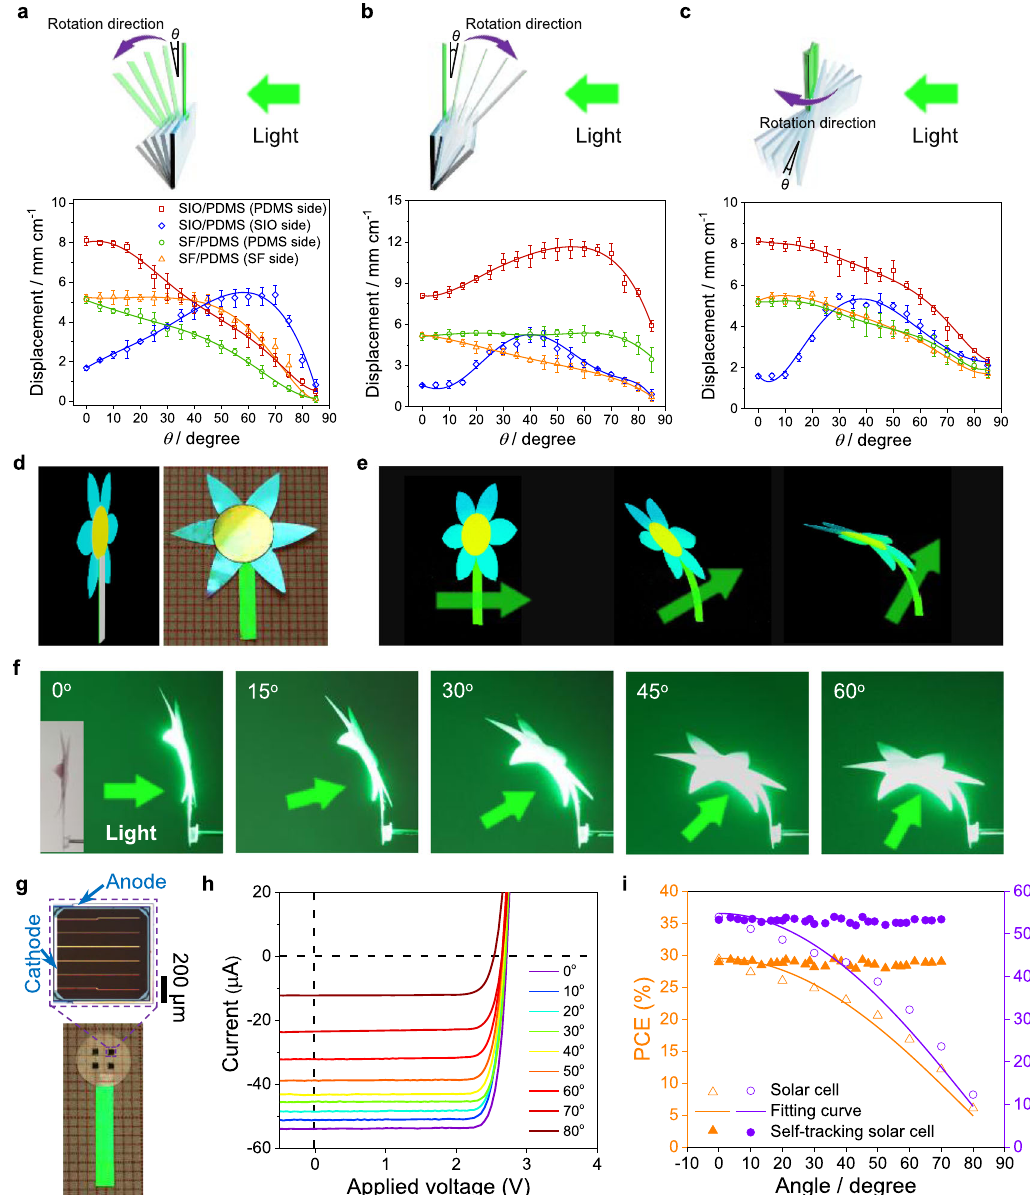
Fig. 4 Angle-dependent actuation and phototropic moving. a – c (Top) Schematics of the rotation direction of the sample with respect to the laser source. The sample was illuminated from either PDMS or SIO/SF side. (Bottom) Dependence of displacement of the bilayers on the rotation angle ( θ ) of the sample ( I = 35 m cm − 2 ). Same legend for a , b , and c . d Schematic (left) and photograph (right) of a photonic sun fl ower. e , f Schematics ( e ) and images ( f ) showing different deformation states of the arti fi cial sun fl ower with different illumination angles ( I = 35 m cm − 2 ). Insert in f indicates the initial state of the sun fl ower before illumination. g Photograph of the self-tracking photovoltaics system made of a photonic bilayer strip and an array of transfer-printed solar cells. Enlarged image shows the structure of one of the transfer-printed solar cells. h Current ( I ) – voltage ( V ) curves of the solar cell at different angles of incidence of light. i Measured power conversion ef fi ciency (PCE) and short-circuit current ( I sc ) as a function of incident angle. Error bars indicate the standard deviation ( n =